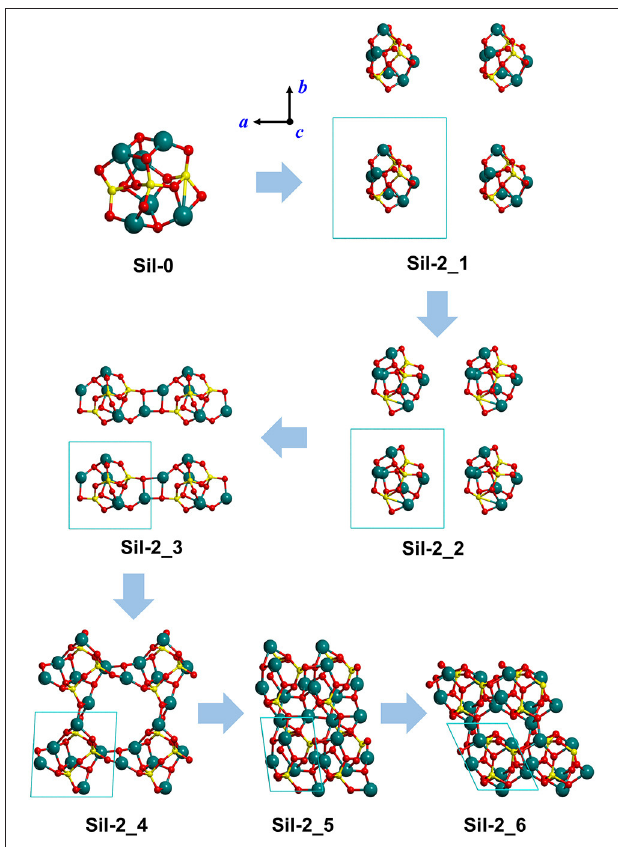
FIGURE 2 | Optimized silicate structures derived from the progressive reduction of the periodic unit cell size as a strategy to mimic proto-silicate aggregation. For Sil-2_1, Sil-2_2, and Sil-2_3, unit cell parameters were fixed to the initial values, while for Sil-2_4, Sil-2_5, and Sil-2_6 they were included in the optimization process. These structures result from the aggregation of the same nanocluster as shown in Figure 1 , but with a different initial rotational orientation within the periodic unit cell. Atom color key: Si—yellow, Mg—blue, O—red.